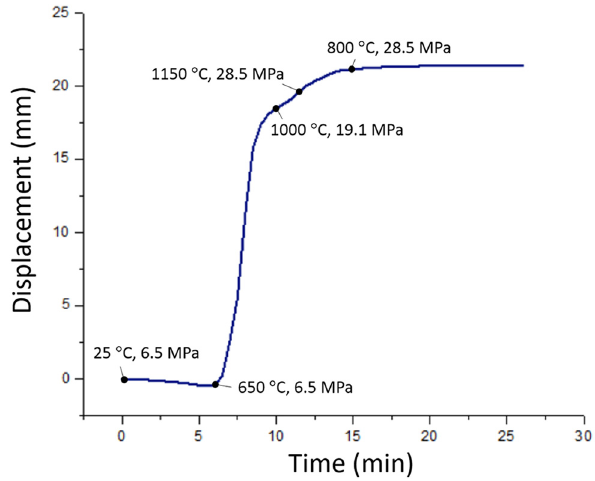
Figure 7: Displacement vs time SPE curve of calcined HA. Relevant temperatures and axial pressures are indicated. Please refer to the text for an explanation.